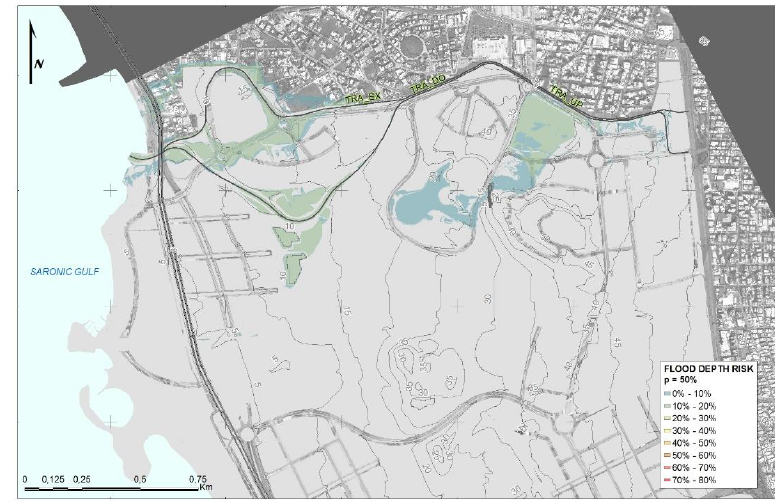
Figure 12. Mapping of flood depth hazard (10% confidence limit).